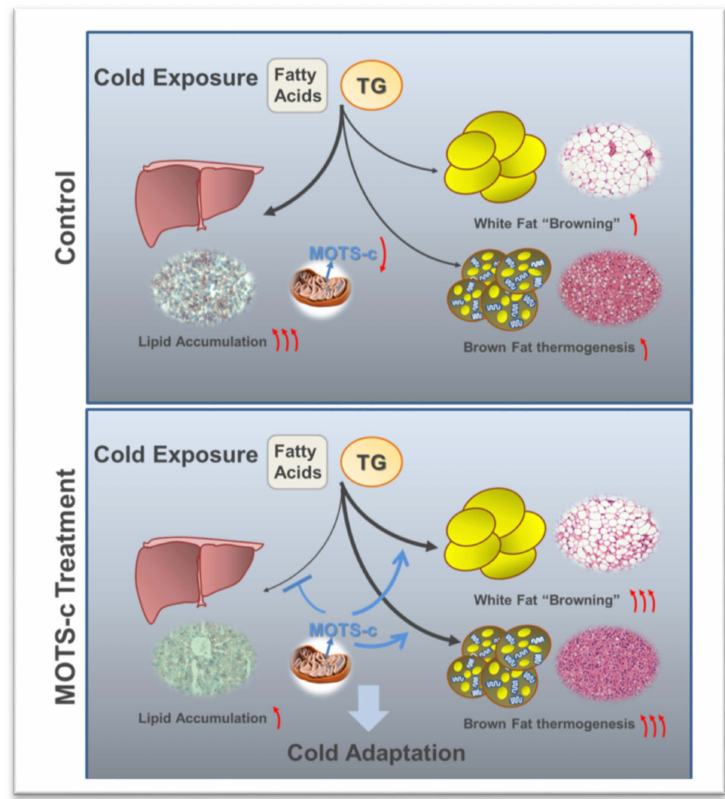
Figure 5. The e ff ect of MOTS-c on lipid metabolism upon cold exposure. MOTS-c administration increases BAT activation and WAT browning to produce heat. And MOTS-c promotes lipid consumption and alleviates acute cold exposure induced elevated TGs and lipid accumulation in serum and liver. Black arrow: TGs and lipid absorbed by liver or BAT and WAT; Blue arrow: the e ff ect of MOTS-c on lipid metabolism and metabolic organs; Red arrow: The change of MOTS-c, lipid content and thermogenic